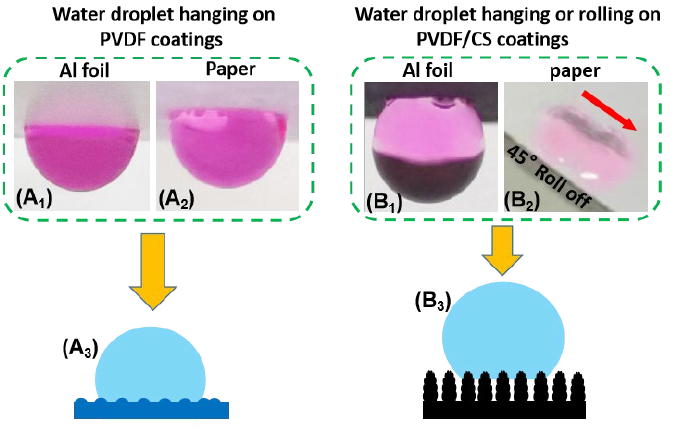
Figure 2. Wetting behavior and regime of the electrosprayed coatings: ( A 1 – A 2 ) and ( B 1 ) water droplets hanging on the coatings at a tilt of 180°; ( B 2 ) water droplet rolling off the coatings at a tilt of 45°; ( A 3 ) and ( B 3 ) schematics of the Wenzel model and the combined Cassie–Baxter/Wenzel model for the corresponding coatings, respectively.